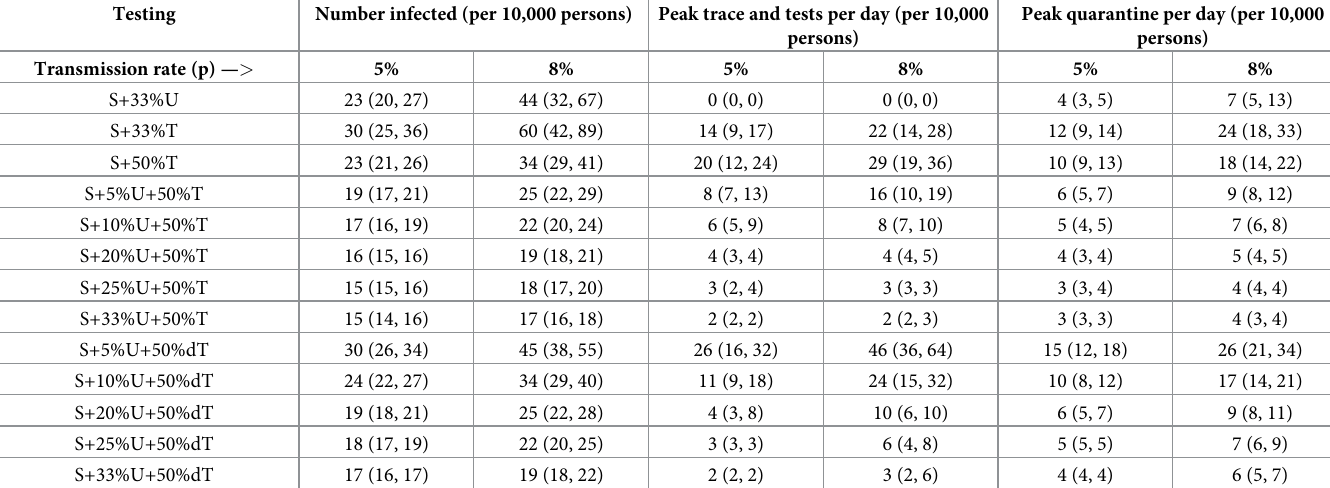
Table 3. Suitable testing options ⁋ for effective control of a disease outbreak keeping contact rates at reported levels † ‡